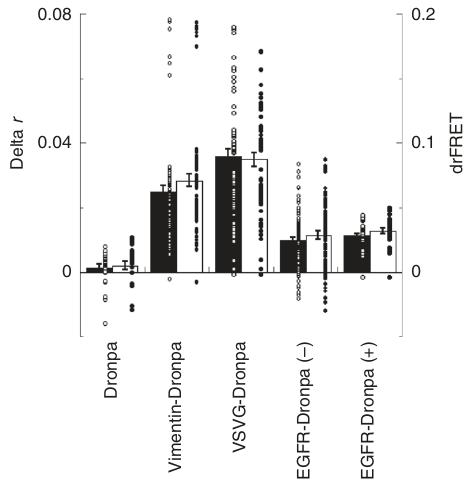
Fig. 5 psAFRET measurements of Dronpa tagged proteins. COS-7 cells expressing Dronpa, Vimentin-Dronpa, VSVGtsO45-Dronpa, or EGFR- Dronpa were imaged and photoswitched. A subset of EGFR-Dronpa expressing cells were also treated with EGF. Dronpa fl uorescence anisotropy was determined and plotted as a function of the fl uorophore photoswitched. The data points representing ∼ 80% of the fl uorescence were fi tted to linear equations and used to determine the difference in anisotropy (delta r, black columns). These were also converted to drFRET ef fi ciency (white columns) using Eq. (2). Data represent mean ± sem ( n = 27, 72, 63, 108, and 30 for Dronpa, Vimentin-Dronpa, VSVGtsO45-Dronpa, EGFR-Dronpa ( − EGF), and EGFR-Dronpa ( + EGF), respectively). Circles overlaid on columns in the bar graphs represent individual data points. Source data are provided as a Source Data fi